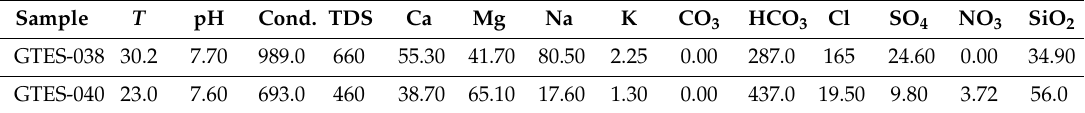
Table 2. Hydrochemical analyses of groundwater samples from Microthives locality [28]. T ( ◦ C); conductivity ( µ S / cm); concentrations (mg / L); total dissolved solids (TDS) (mg /